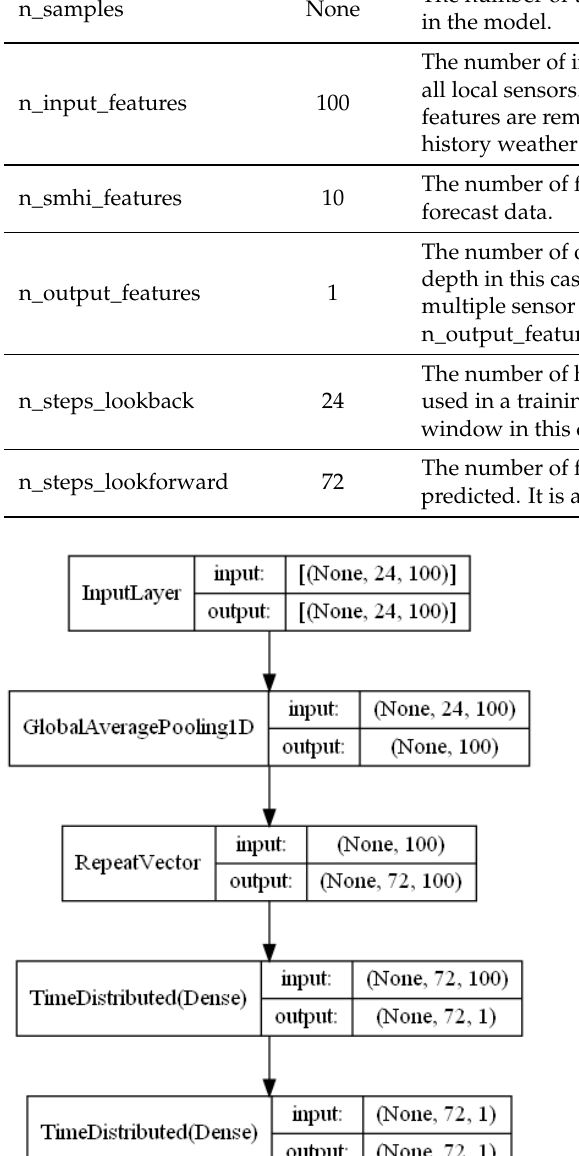
Figure 6. Functional unit that maps local sensor data to the